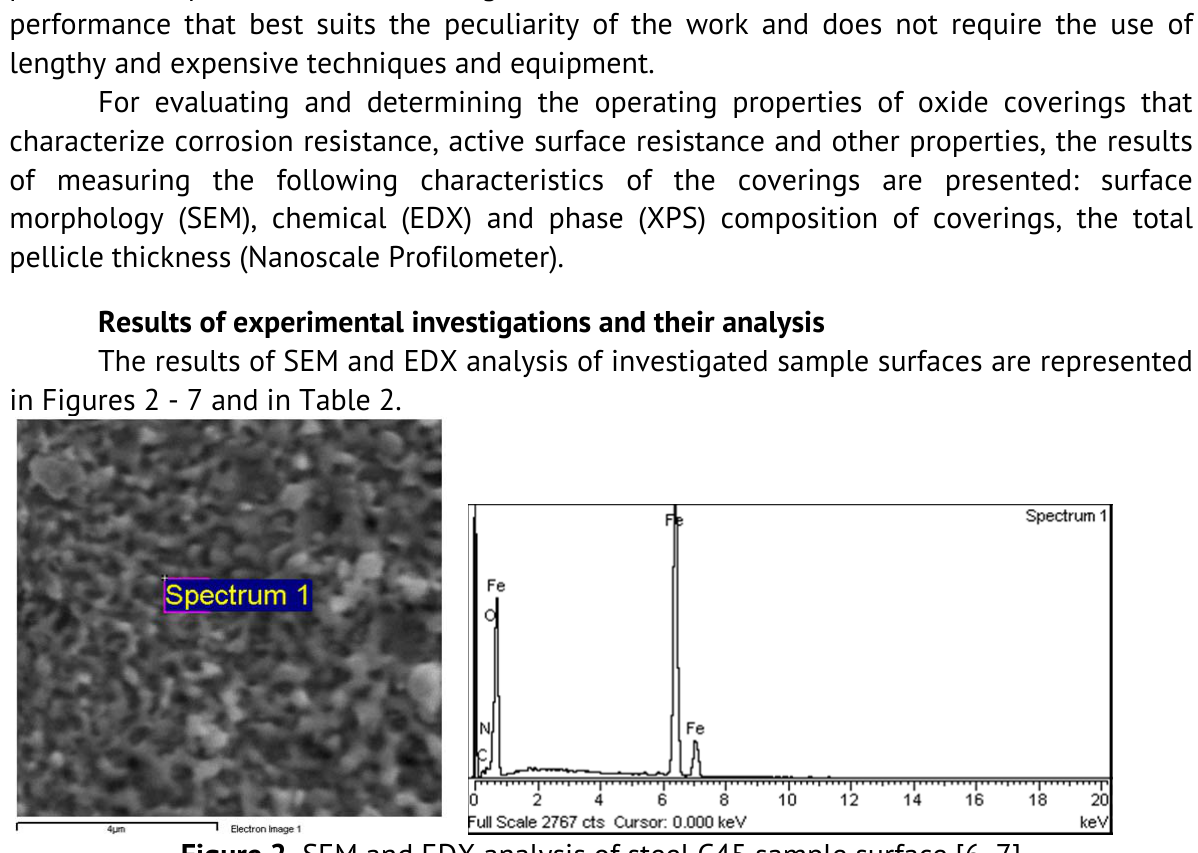
Figure 1. Technological schemes of the oxide pellicle formation by applying EDI: a) on the plane surface with plane tool-electrode; b) on the plane surface with a semi-circular tool-electrode; c) on the external cylindrical surfaces